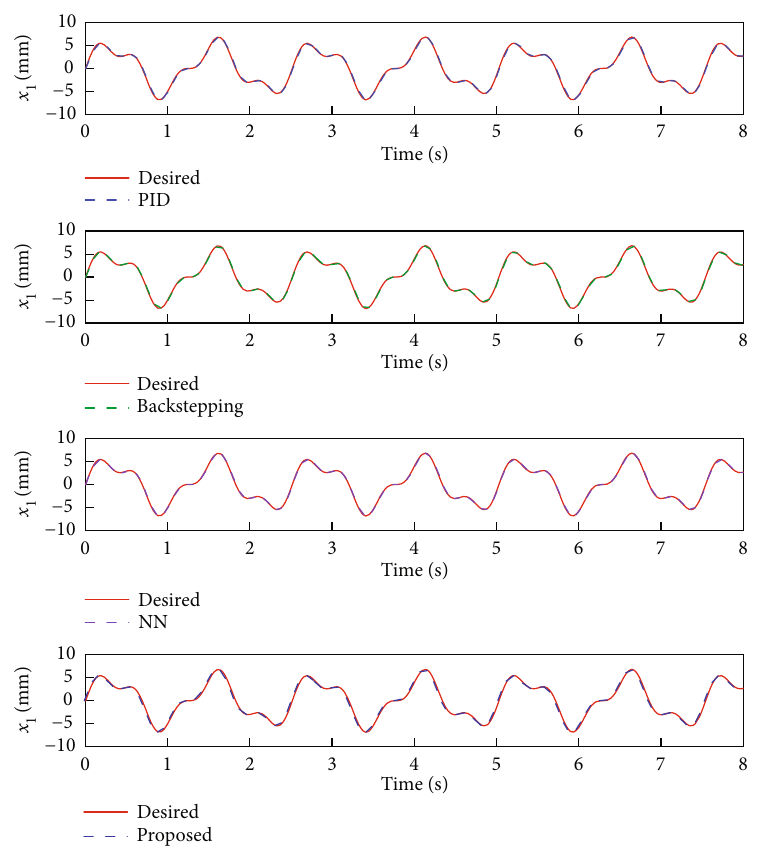
Figure 4: Tracking performance of multifrequency sine